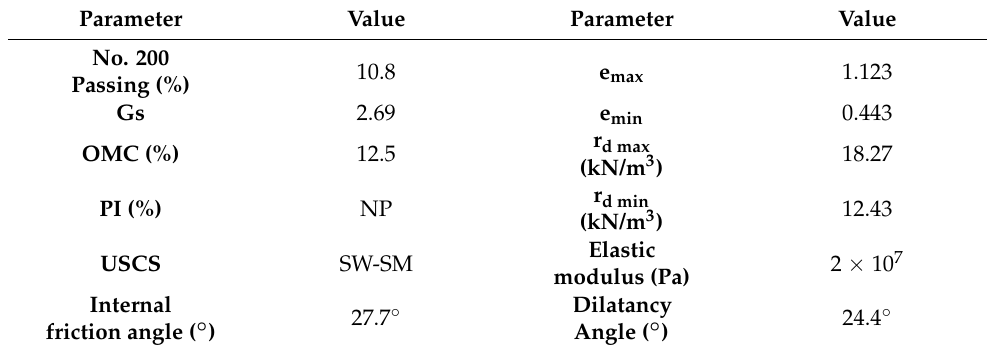
Table 1. Geotechnical index properties of the specimen (loose ground) used in this study (Jin et al. [12]).